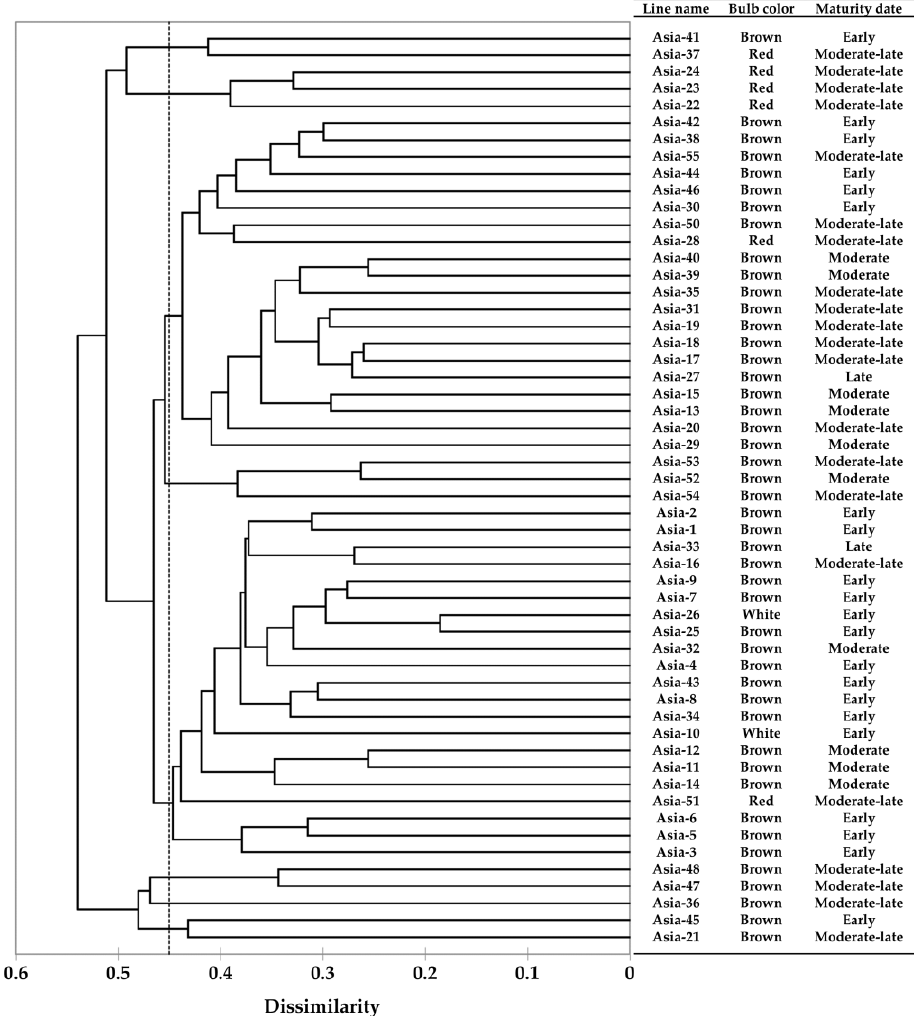
Figure 1. Dendrogram of 54 onion lines provided by Asia seed Co., Ltd. (Seoul, Korea) by RAPD analysis and information on the bulb color and maturity date of each line.